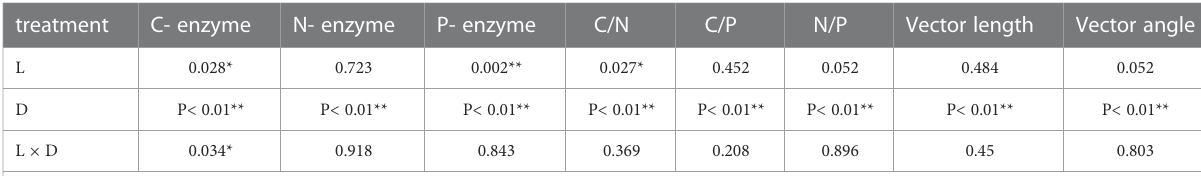
TABLE 1 Results of a two-way ANOVA for degraded levels and litter types.